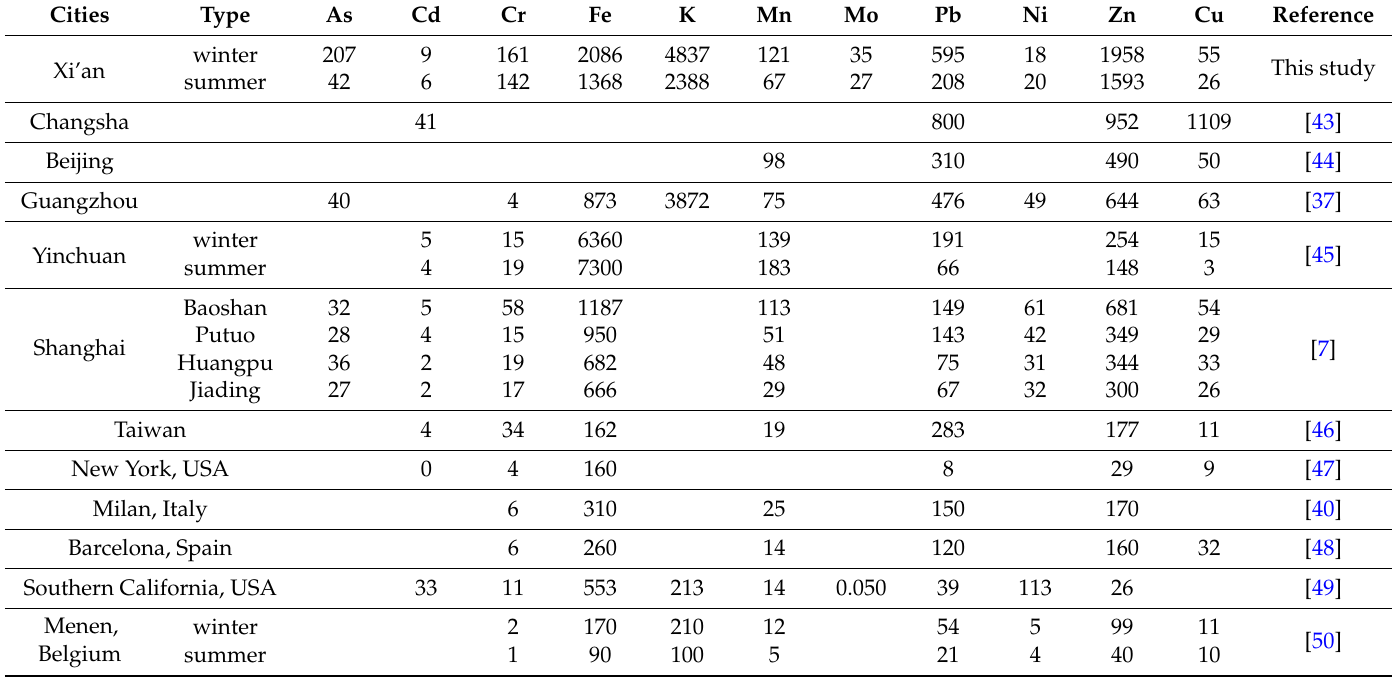
Table 3. Comparison of eleven elements concentrations measured in PM 2.5 in this study and in other sites (Unit: ng m − 3